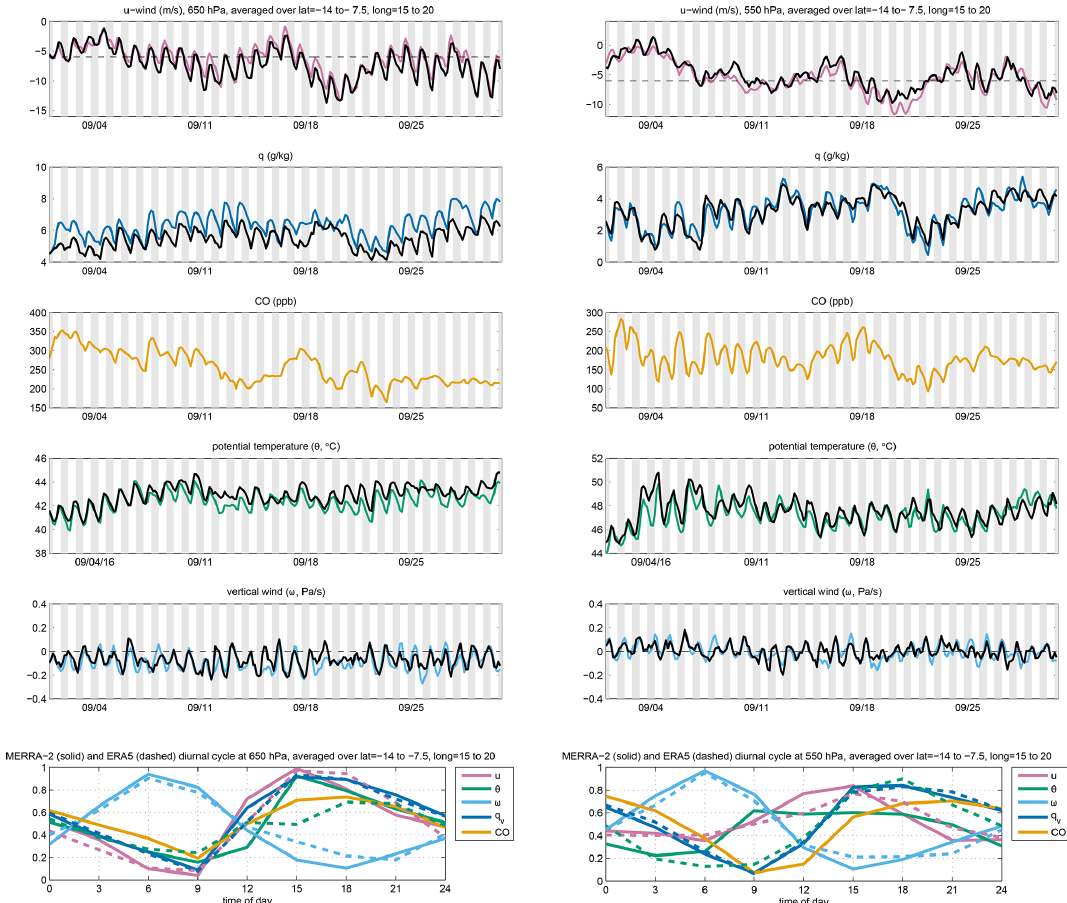
Figure 12. Time series of (top to bottom) zonal winds ( u ; m/s), specific humidity ( q ; g/kg), CO (ppb), potential temperature ( θ ; ◦ C), and vertical velocity ( ω ; Pa/s), at 650hPa (left) and 550hPa (right) for MERRA-2 (colored lines) and ERA5 (black lines) reanalyses. Distinct diurnal cycles are seen for all variables except CO at 650hPa, where variability is dominated by multi-day changes rather than a strong diurnal cycle. The 650 and 550hPa panels for a given parameter are on the same scale so as to highlight differences in diurnal cycle magnitudes with altitude, though shifted to capture the full range at each level. Shading indicates night (18:00–06:00UTC). The horizontal dashed line in the u panel shows the 6m/s AEJ-S wind speed threshold (Adebiyi and Zuidema, 2016), and the horizontal dashed line in the ω panel shows the 0Pa/s threshold which separates rising ( − ω ) from sinking ( + ω ) vertical motion. Note that easterly u winds are given by negative values. The bottom panel shows the composite diurnal cycle for each variable from MERRA-2 (solid) and ERA5 (dashed) overlaid on one another (colors the same as above), normalized to a diurnal minimum of 0 and maximum of 1 and then averaged over all September